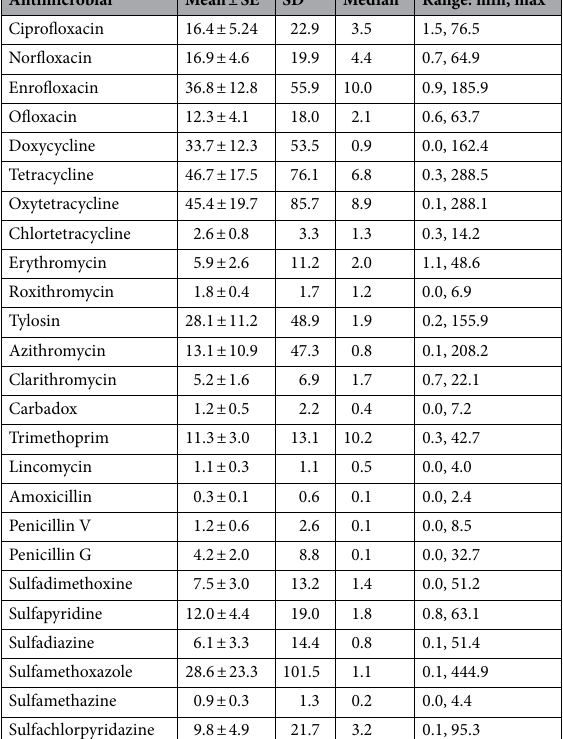
Table 2. Summary statistics (arithmetic mean ± standard error, standard deviation (SD), median, and range: minimum (min) and maximum (max)) for antimicrobial concentrations analyzed in water samples (ng/L) across sites in 2019 (n =